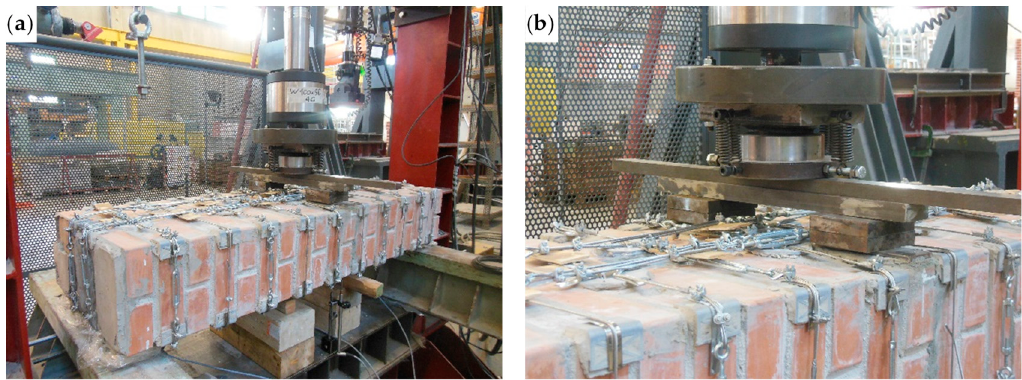
Figure 46. The flat steel bars for load distribution on the middle cross-section: ( a ) overview of the loading system and ( b ) detail of the passage of the steel wire ropes under the loading piston.